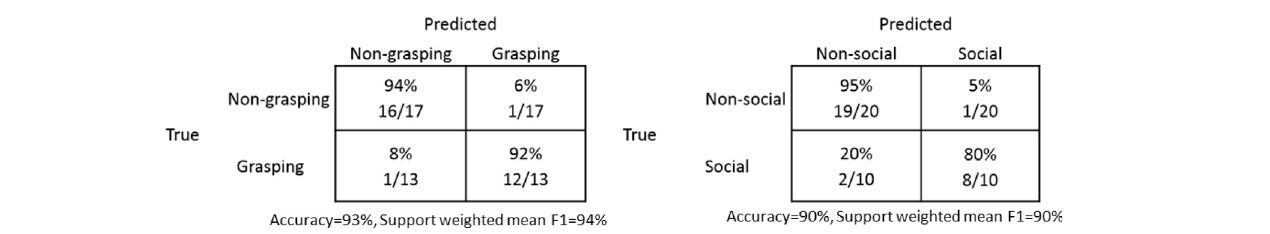
TABLE 4 | Confusion matrices for human judgments of gestures as a function of judgment task (grasping and